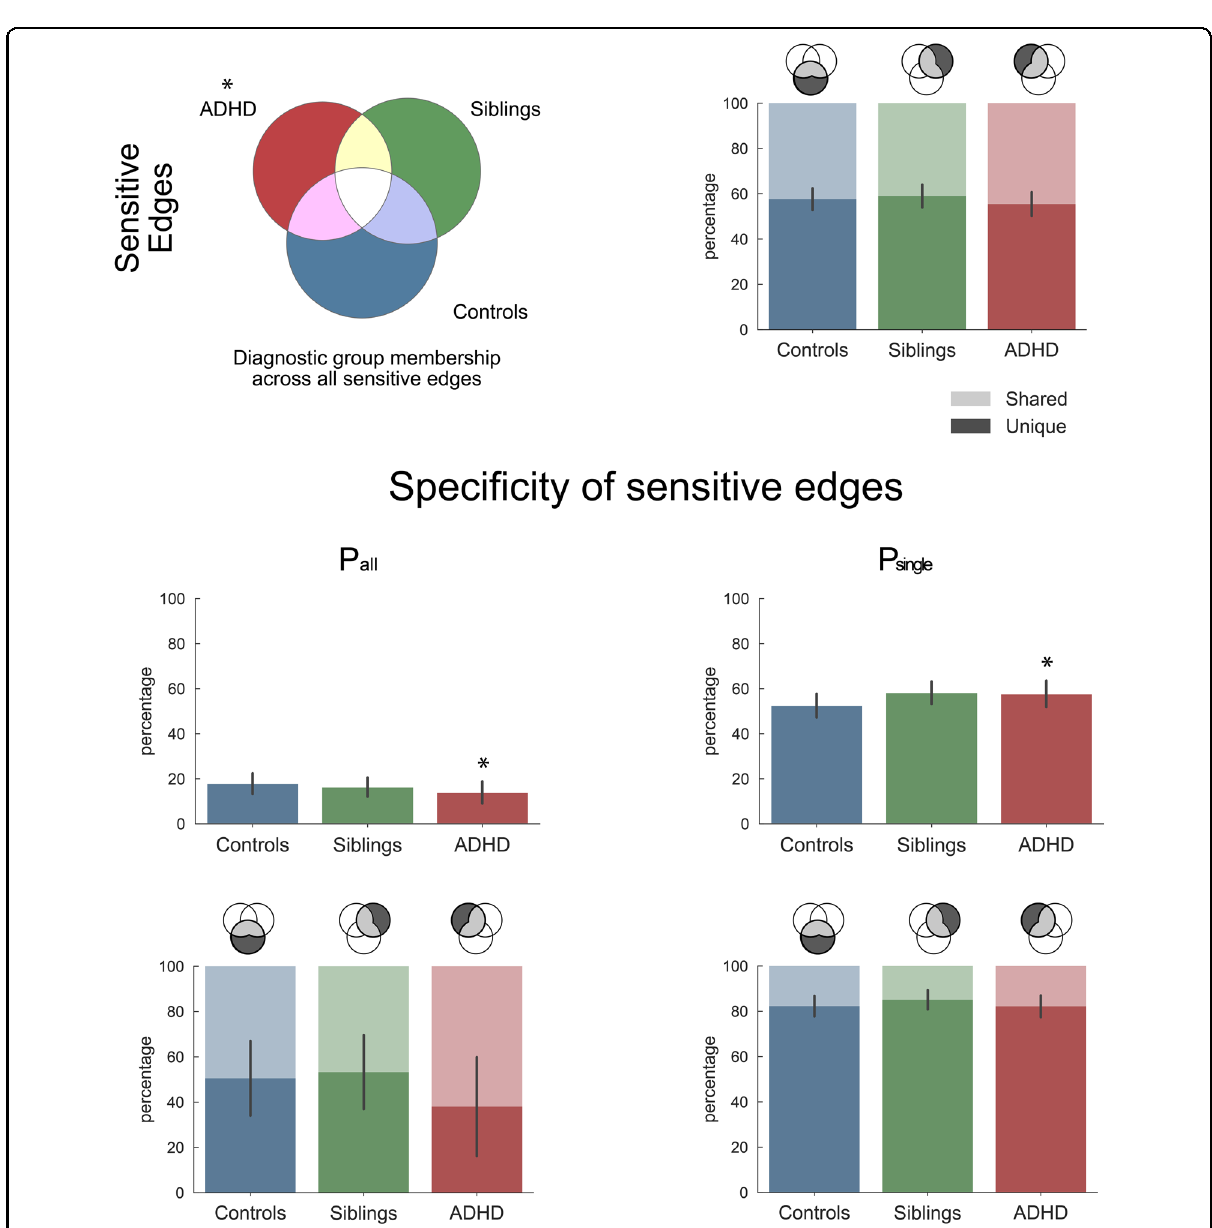
Fig. 1 Sensitivity to task modulation. Description of total connectivity modulations across the three tasks and diagnostic groups (ADHD, siblings, controls). The fi rst row shows for each group the percentage of connections they modulated across the three tasks (sensitive connections) and within these selected connections, the relative percentage of connections unique to one group or shared across groups. We further split the selected connections of each group into task-speci fi c ( P single ), and common ( P all ) connections, corresponding to connections modulated in only one, or all three tasks, respectively. The second row of this fi gure quanti fi es the relative percentage of each connection type ( P all and P single ) within the sensitive connections of each group. For the connections described in the second row, the third row then quanti fi es whether these connections were unique to that group or shared across groups. Stars indicate signi fi cant differences from null distribution after FDR correction (see Table S7). Replication of these fi ndings across possible confounding effects (scanner, gender, medication, comorbidity, age, IQ) is available in Figs. S1 and